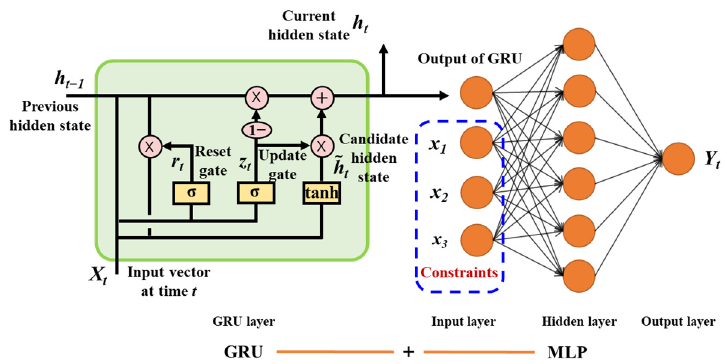
Figure 3. Schematic of a GRU-MLP combined neural network [15].